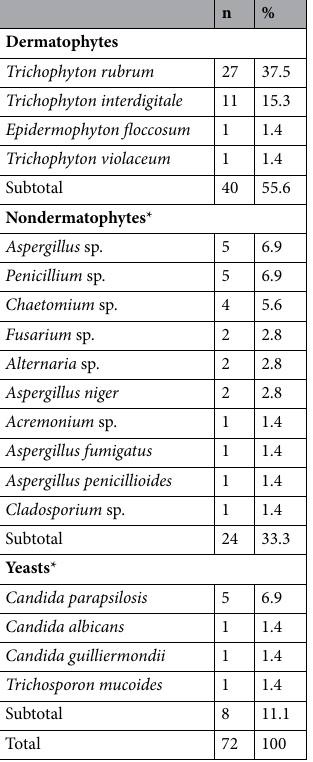
Table 2. Distribution of species identified in nail plate samples of Hospital Patients Group (HosPG). Data are n (%). *Some strains are colonization or contaminants.